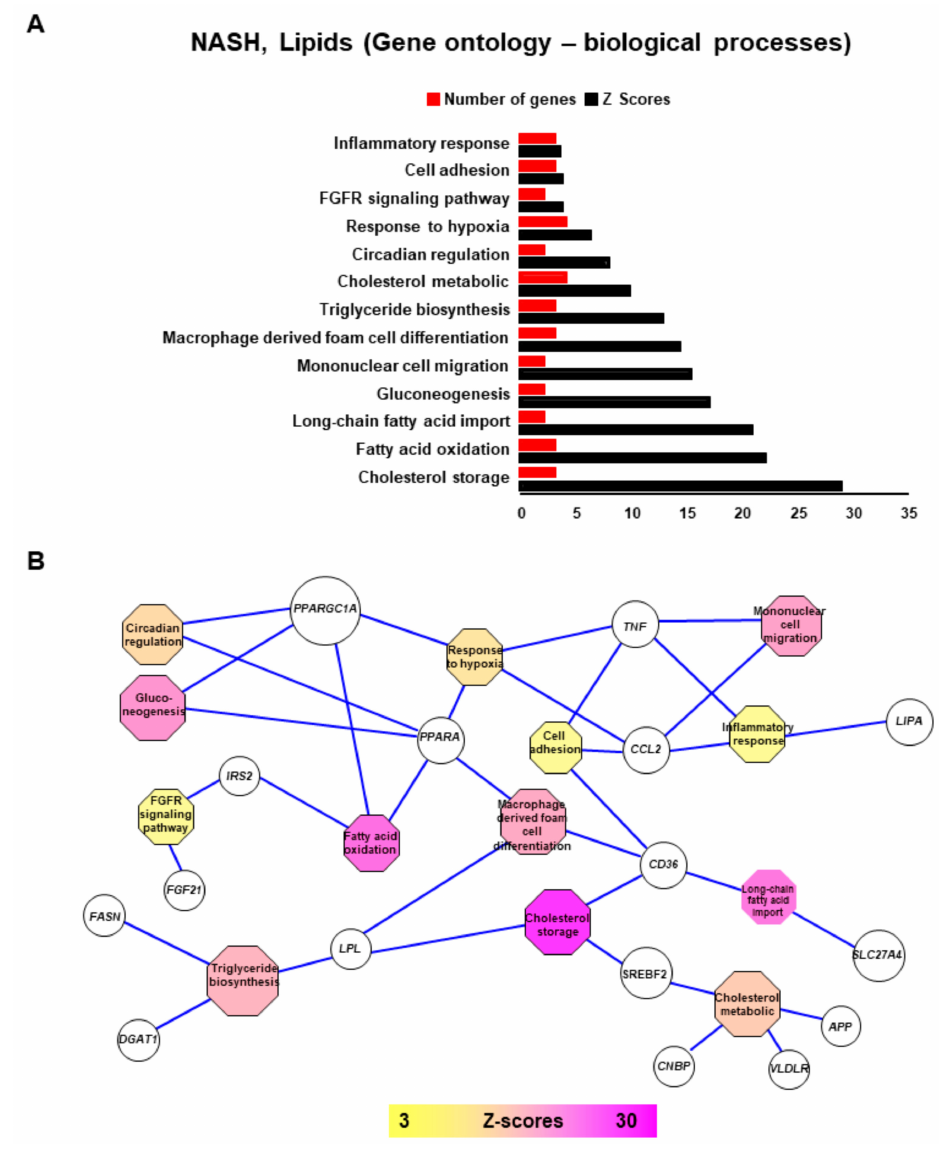
Figure 4. Ontologic functional enrichment network of lipid-related genes deregulated in NASH liver samples. ( A ) Bar plot of functional enrichment performed with lipid related genes deregulated in NASH on Gene Ontology Biological Process database: red bars represent number of genes implicated by function and blue bars respective Z-scores of the enrichments. ( B ) Functional enrichment network performed with lipid related genes deregulated in NASH (Gene ontology biological